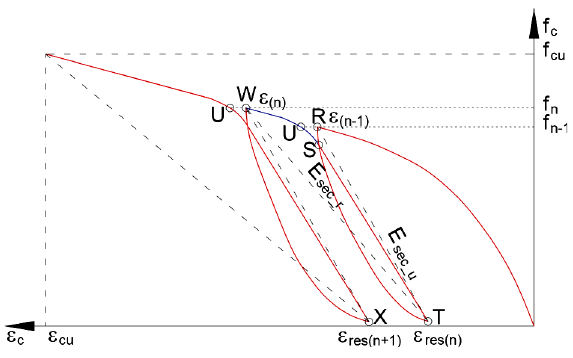
Fig. 9. σ -ε relationship through cyclic loading